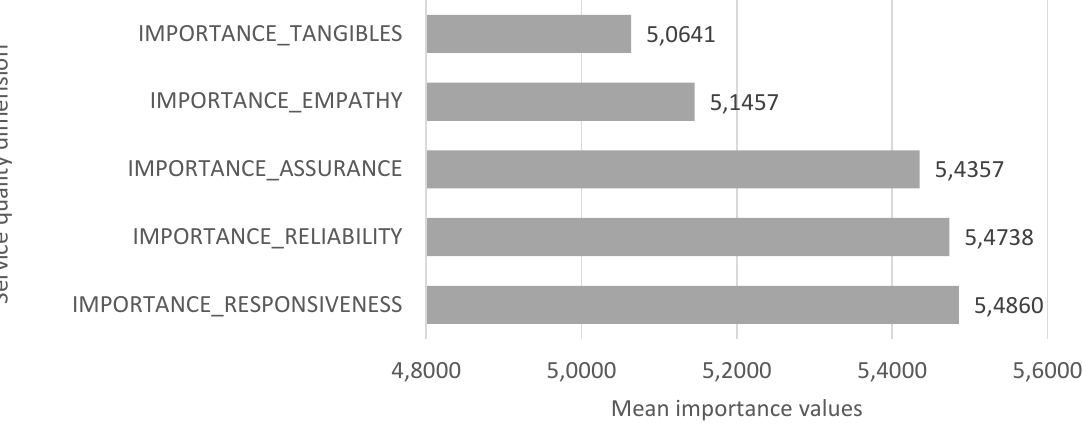
Figure 2. Importance of service quality